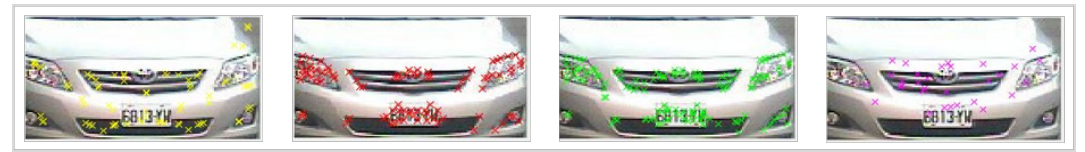
Figure 5. Detected feature points using KAZE, FAST, BRISK and SURF feature detectors